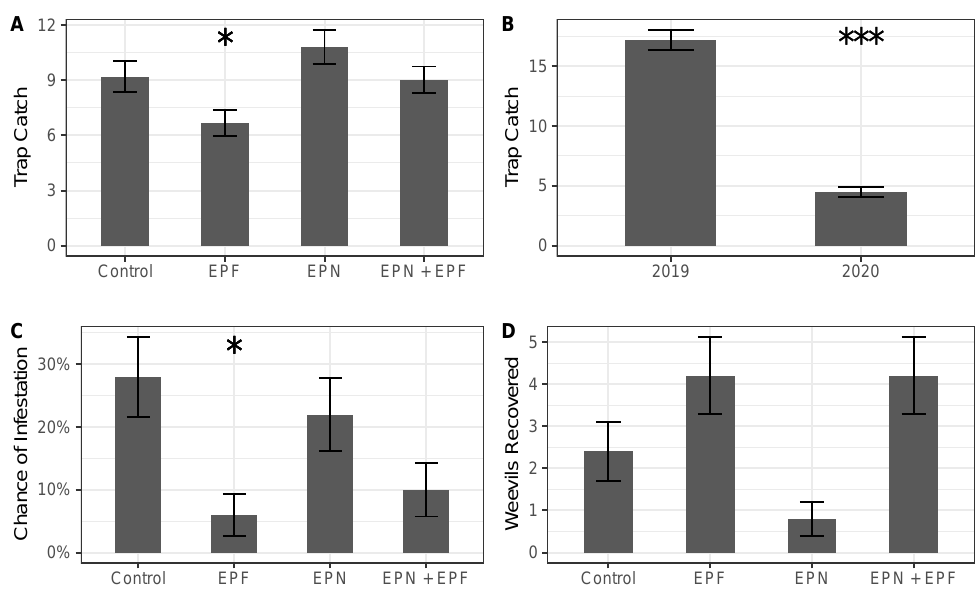
Figure 4. Biological control of C. sayi . ( A ) Effect of biological control treatments on C. sayi adult trap catch in a commercial chestnut orchard. Bars and error bars denote rate of trap catch in each treatment on a per trap basis and standard error, respectively. Single asterisk denotes a significant ( p < 0.05) difference from the control treatment. ( B ) C. sayi adult trap catch in each year of this study. Bars and error bars denote rate of trap catch in each year on a per trap basis and standard error, respectively. Multiple asterisks denote significant ( p < 0.001 ) difference from 2019. ( C ) Likelihood of a nut from a given treatment being infested by C. sayi larvae. Bars and error bars denote the chance of a nut from a given treatment being infested with C. sayi larvae and the standard error, respectively. Single asterisk denotes the significant ( p < 0.05) difference from the control treatment. ( D ) C. sayi recovered from microcosms by treatment. Bars and error bars denote weevils recovered by treatment and standard error, respectively. Single asterisk denotes significant ( p < 0.01) difference from EPN+EPF treatment and marginally significant ( p = 0.09) difference from the